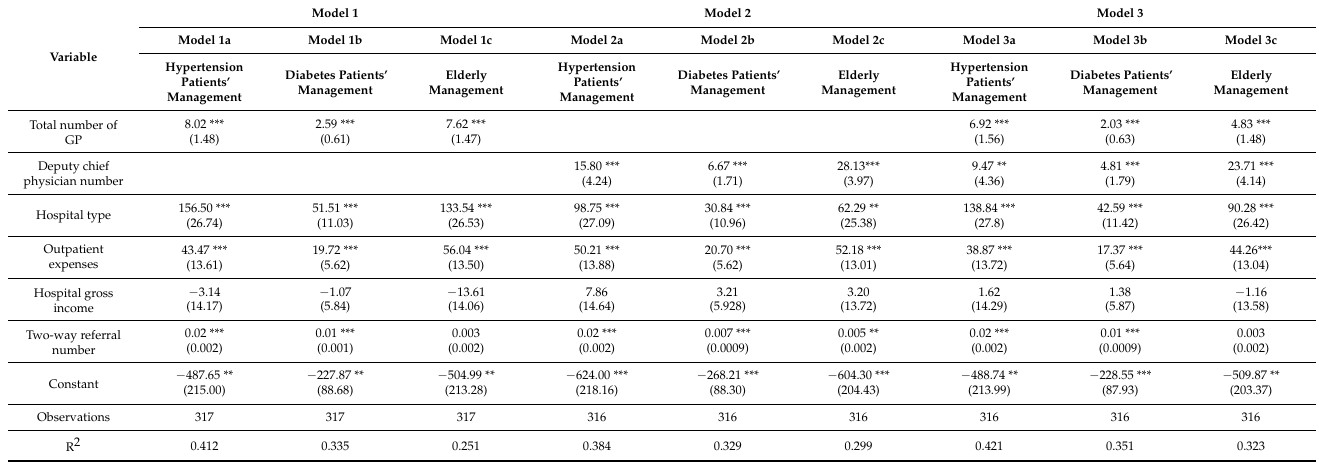
Table 8. Regression analysis results for Model 1–Model